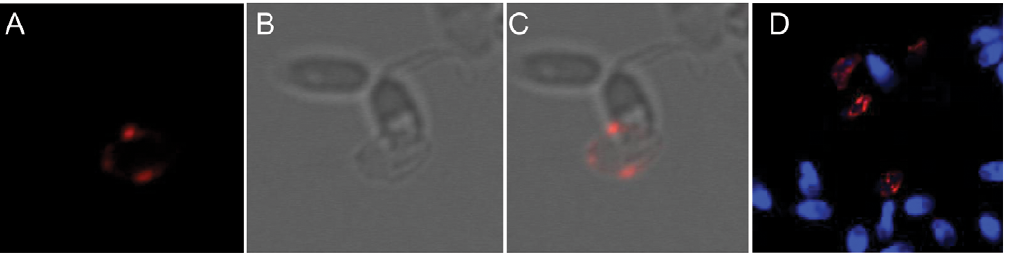
Figure 4. Binding pattern of HPV to sperm using fluorescence in situ hybridization with HPV type-specific probes. ( A–C ): Close-up picture of sperm of which one is positive for HPV type 18. Picture B shows the sperm present in picture A, captured by differential interference contrast (DIC). Picture C shows an overlay of A and B. ( D ): Close-up picture of HPV-negative and HPV-18 positive sperm cell from an HPV-18-positive semen sample stained for HPV (red) and DNA (blue). Note the lack of DNA staining characteristic of the majority of HPV positive sperm. Lack of or decreased DNA staining was seen in all HPV-positive sperm.